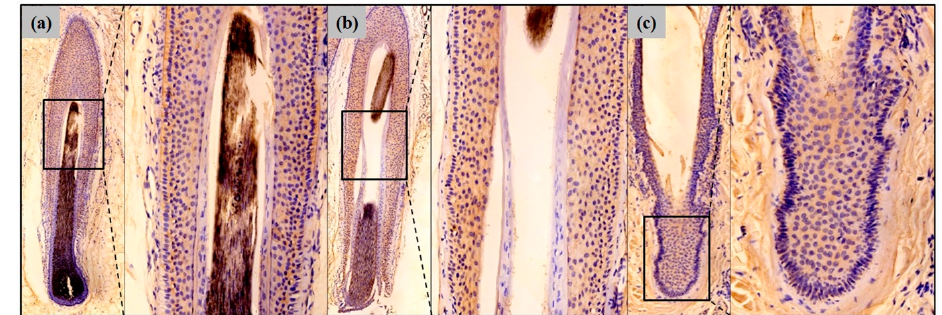
Figure 2. Erdr1 expression in a healthy scalp hair follicle; ( a ) Erdr1 expression in the anagen phase of the follicle; A high-power image of Erdr1-positive cells in the outer root sheath of the follicle is shown; ( b ) Healthy hair follicle in the catagen phase; A high-power image of Erdr1-positive cells in the outer root sheath of the catagen hair follicle is shown; ( c ) Erdr1 expression in the telogen phase; Erdr1 immunostaining, original magnification ( a – c ) ×50; inserts ×200.